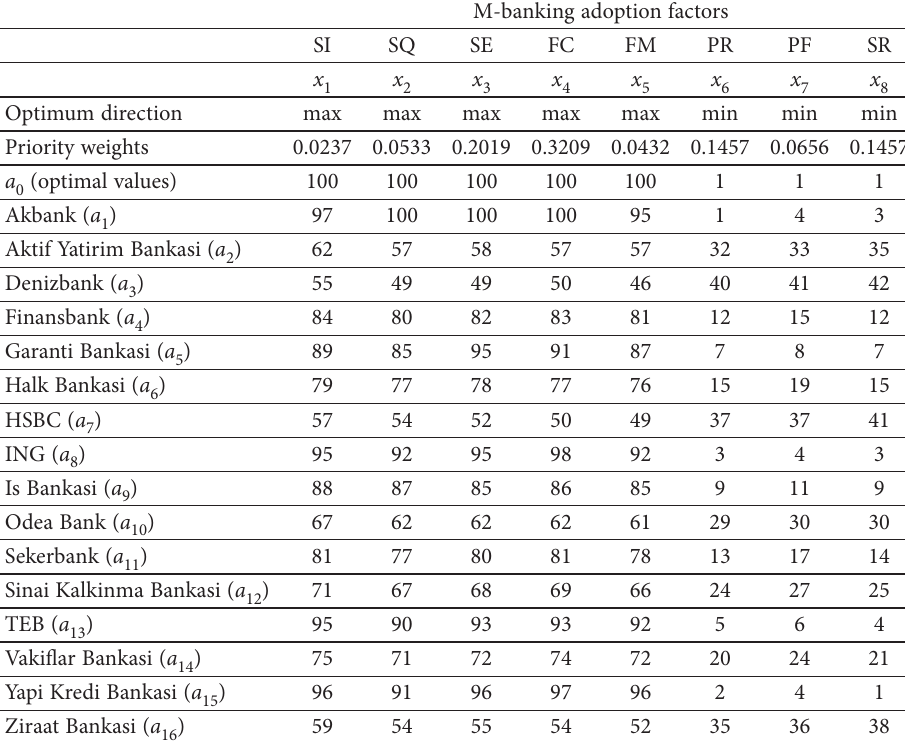
Table 10. Determined initial data for analysis (initial decision making matrix)